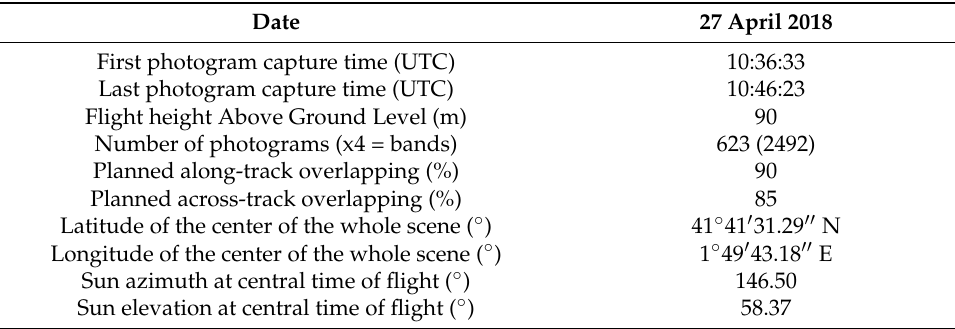
Table 2. Field spectroradiometer main features (OceanOptics USB2000+).